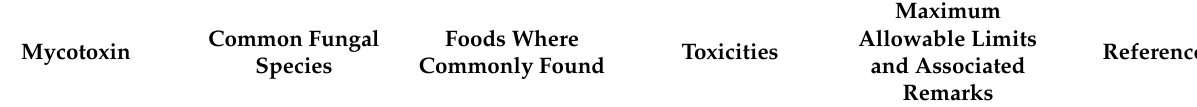
Table 1. Major common mycotoxins, their (established/evolving) toxicities, and maximum allowable limits.